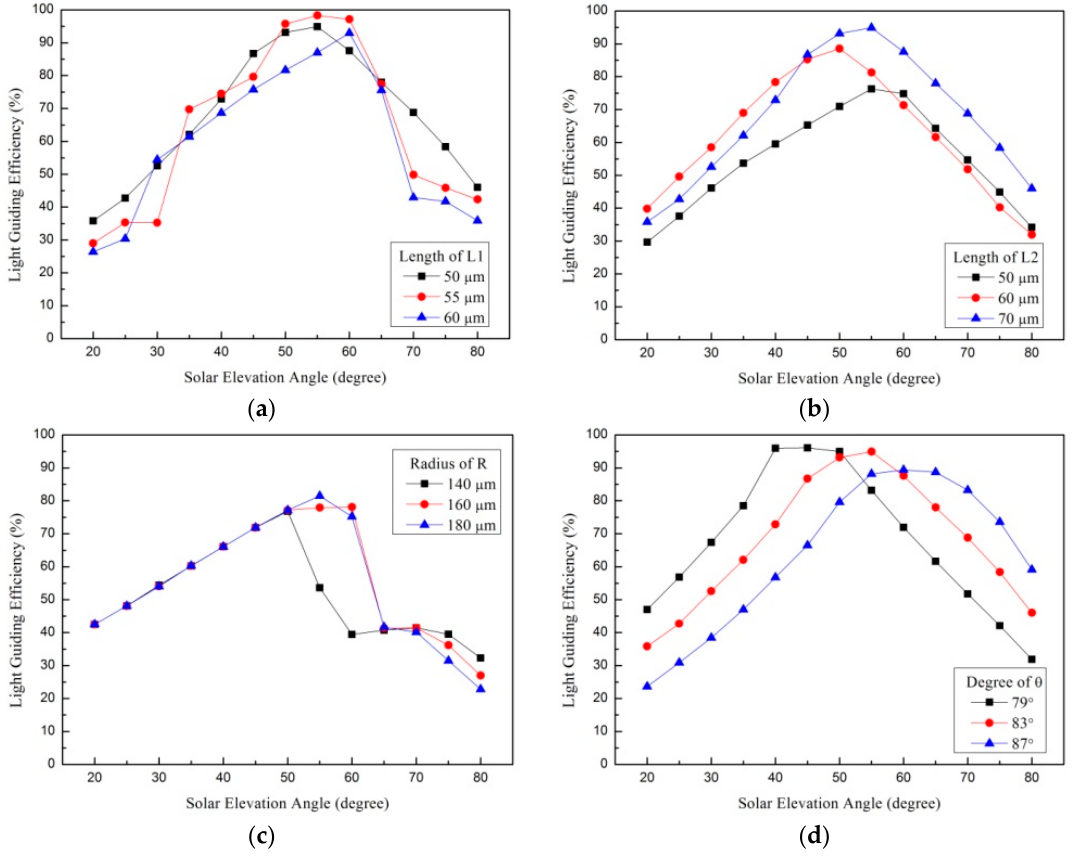
Figure 7. Analysis results of the structural optimization of the polygonal prism. Influence of ( a ) L 1, ( b ) L 2, ( c ) R , and ( d ) θ on the light-guiding efficiency of the sunlight guiding panel.